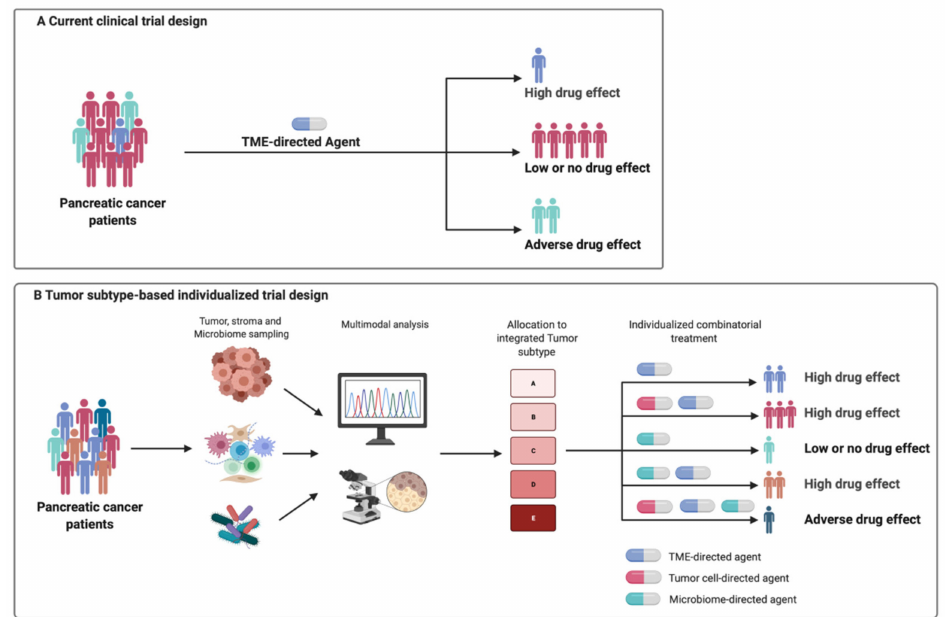
Figure 2. Current and future therapeutic concepts for the treatment of pancreatic cancer patients. ( A ) In current clinical trials, pancreatic cancer patients are not stratified according to distinct tumor and stroma characteristics. Accordingly, the given therapy exerts an anti-tumor effect only in few patients. However, in the majority of patients this strategy fails or has even adverse effects. ( B ) A tumor subtype-based individualized trial design implies sampling of the patient’s tumor, stroma and microbiome prior to treatment and multimodal analysis of these samples will generate an integrated tumor subtype for each patient. Considering these tumor, stroma and microbiome characteristics, the identified subtype allows stratification of pancreatic cancer patients for the treatment strategy with the best predicted outcome. Figure created with